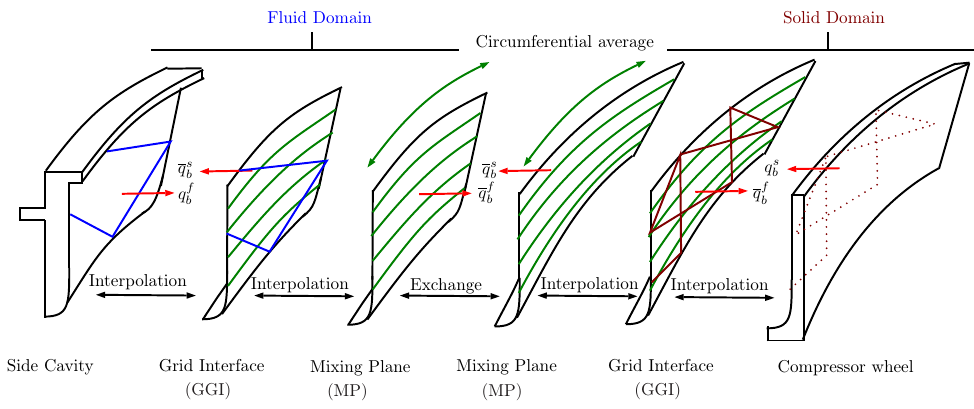
Figure 2. Proposed dual interface mixing plane approach